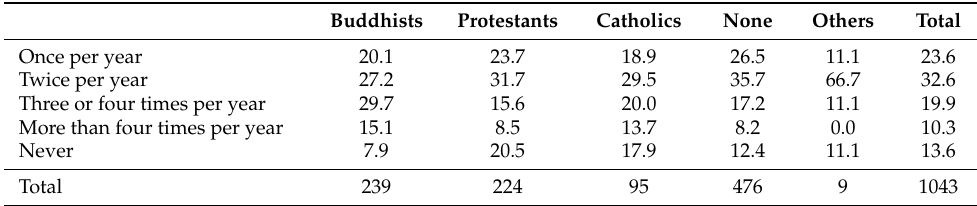
Table 7. Conducting ancestral rites at a gravesite (%), 2016